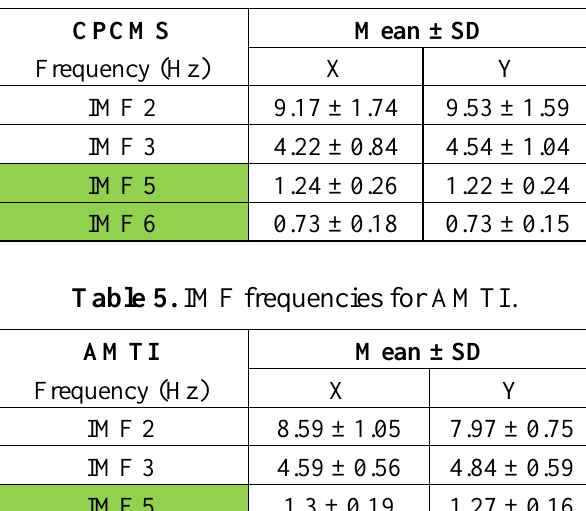
Table 4. IMF frequencies for CPCMS.